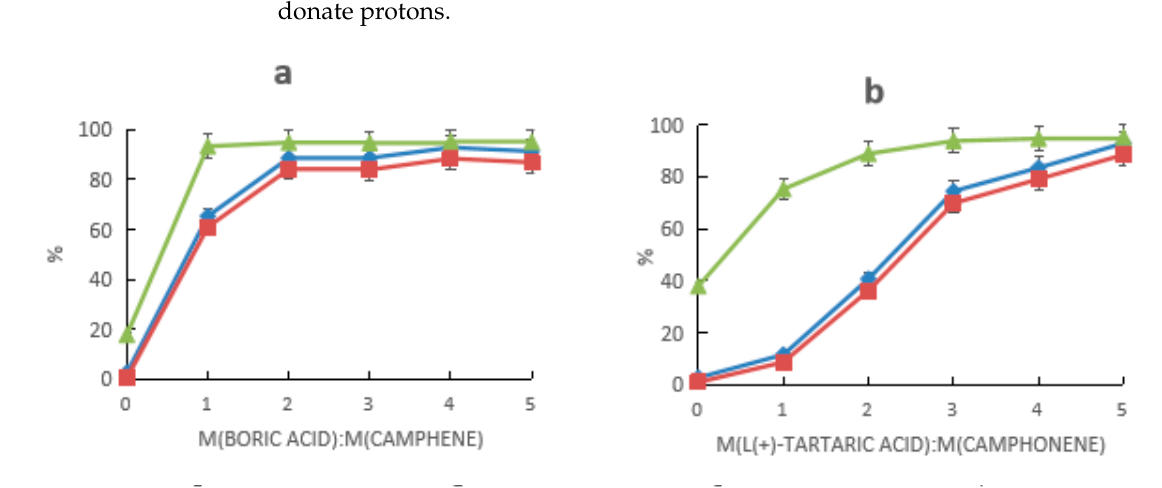
Figure 1. Effect of composition changes of the tartaric acid–boric acid composite catalyst on the catalytic performance. ( a ) Effect of tartaric acid on the catalytic performance under the following reaction conditions: m(camphene):m(acetic acid):m(boric acid) = 10:25:0.4 (where m refers to mass ratio), reaction temperature of 70 ◦ C, and reaction time of 18 h. ( b ) Effect of boric acid on the catalytic performance under the following reaction conditions: m(camphene):m(acetic acid):m(tartaric acid) = 10:25:0.5, reaction temperature of 70 ◦ C, and reaction time of 18 h.